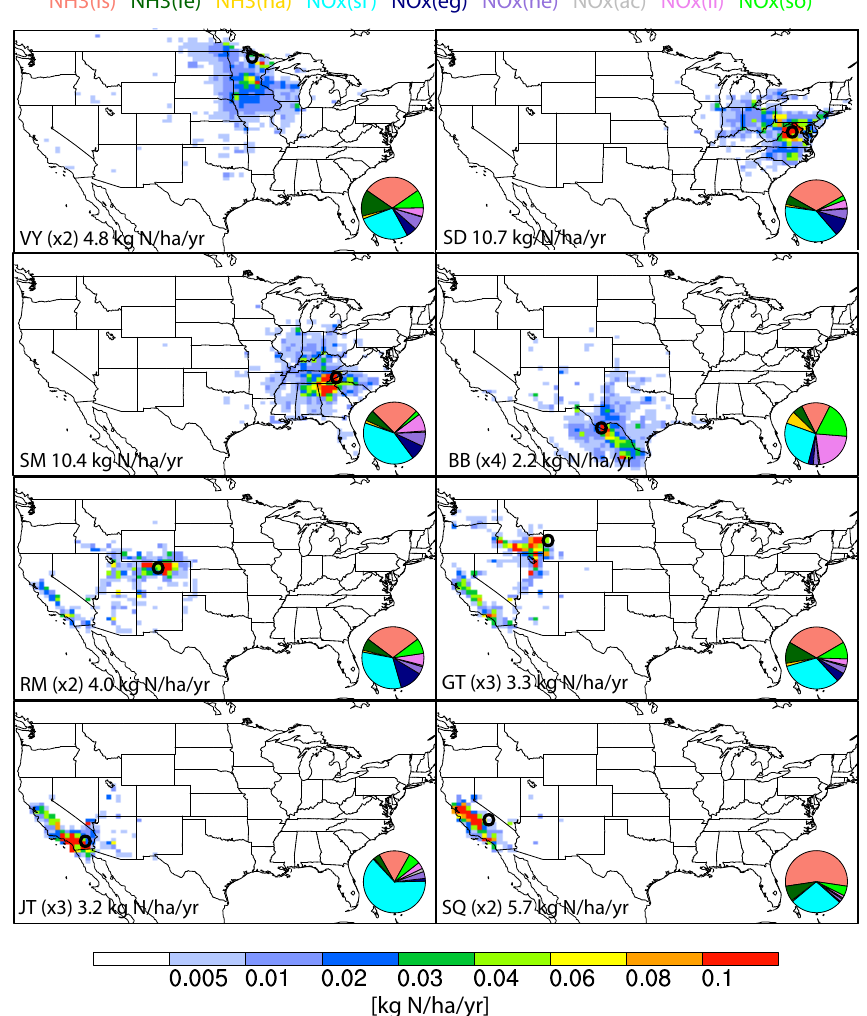
Figure 5. Annual-averaged monthly footprint ( χ ) of Nr deposition in each Class I area and pie chart of fractional contribution from emission sectors. ls: livestock, fe: fertilizer, na: natural, sf: surface inventory, eg: electric generating units, ne: non-eg industrial stacks, ac: aircraft, li: lightning, so: soil. Inset numbers are cost function ( J p ), annual Nr deposition in each Class I area. Site locations are shown with open circles. Footprint values are scaled for visibility with numbers in